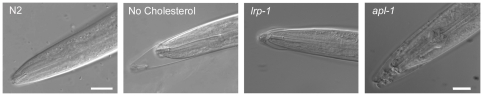
Similar molting defects are seen during cholesterol starvation and apl-1 loss.N2 worm at the L2 stage compared to arrested L2 worms from the second generation grown on a cholesterol-free diet, lrp-1(ku156) mutant and apl-1(tm385) arrested at the L1/L2 molt. (Scale bars, 10 µm).